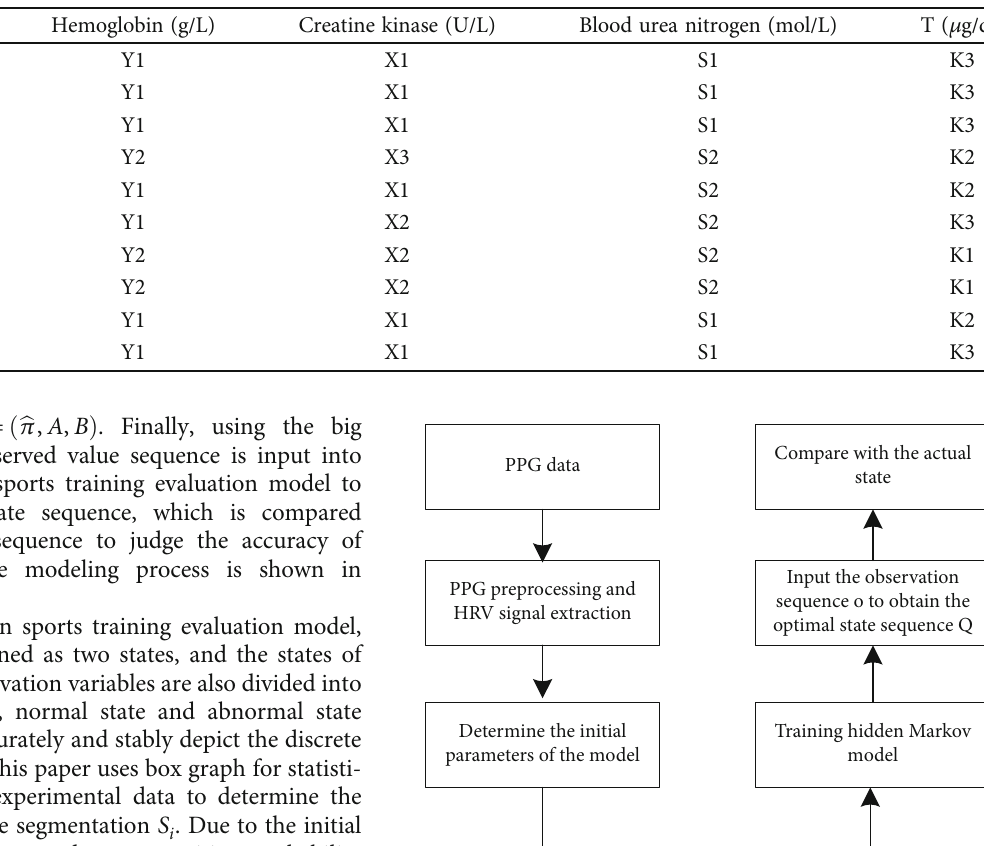
Table 2: Simpli fi ed data of biochemical indexes of sports training.